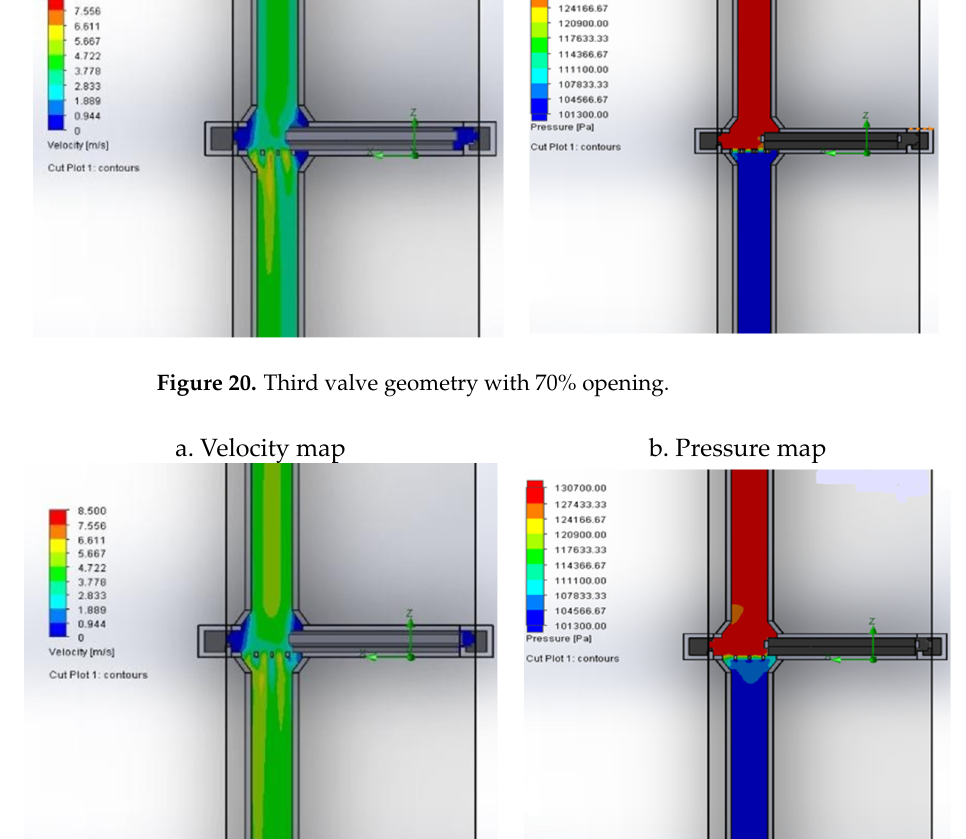
Figure 21. Third valve geometry with 90% opening.